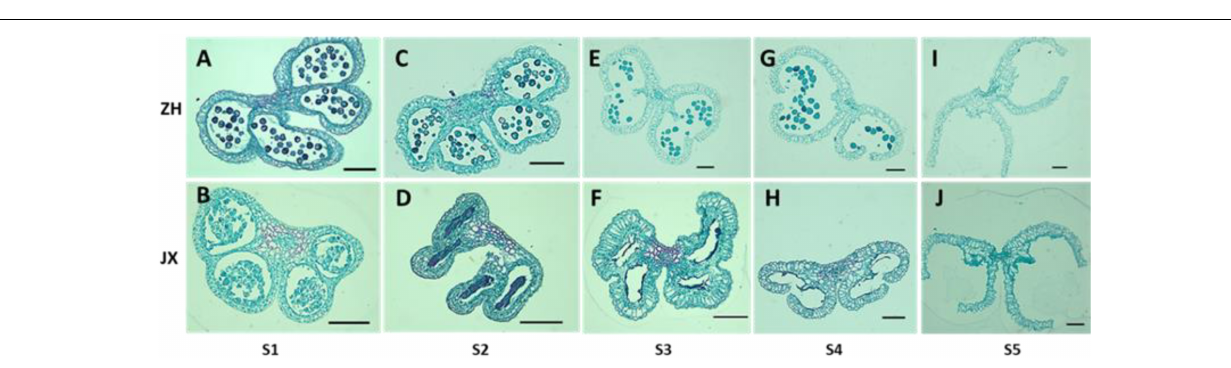
Frontiers in Plant Science |